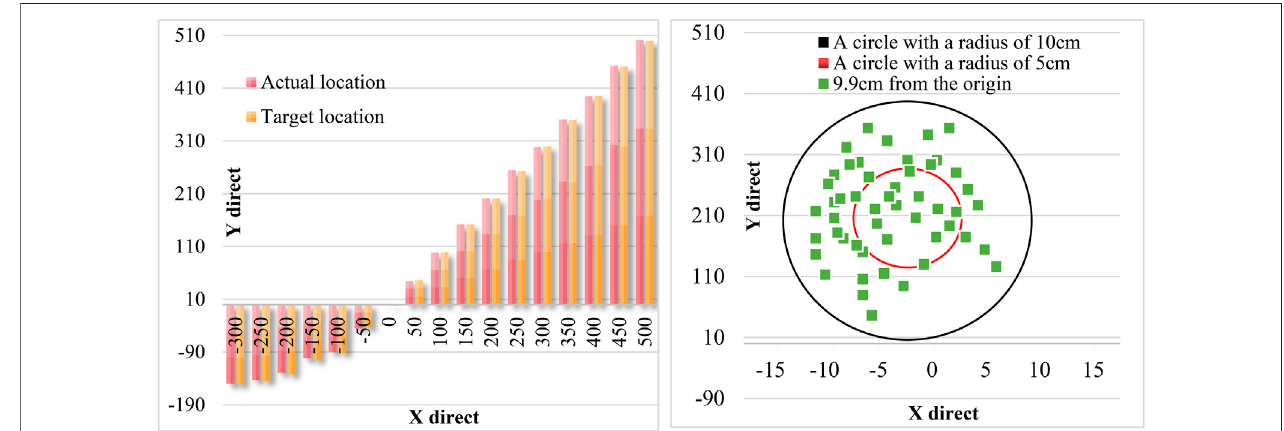
FIGURE 12 | Position comparison diagram and static error